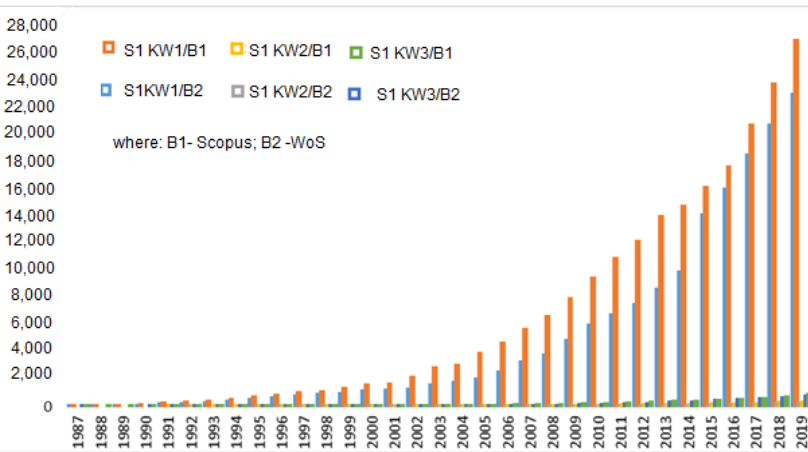
Figure 4. Dynamics of publishing for particular keywords (KW) in the segment S1 “Sustainability”. Source: Own study based on the databases: Web of Science and Scopus. Moreover, the number of scientific papers in recent years was compiled in Table 2.